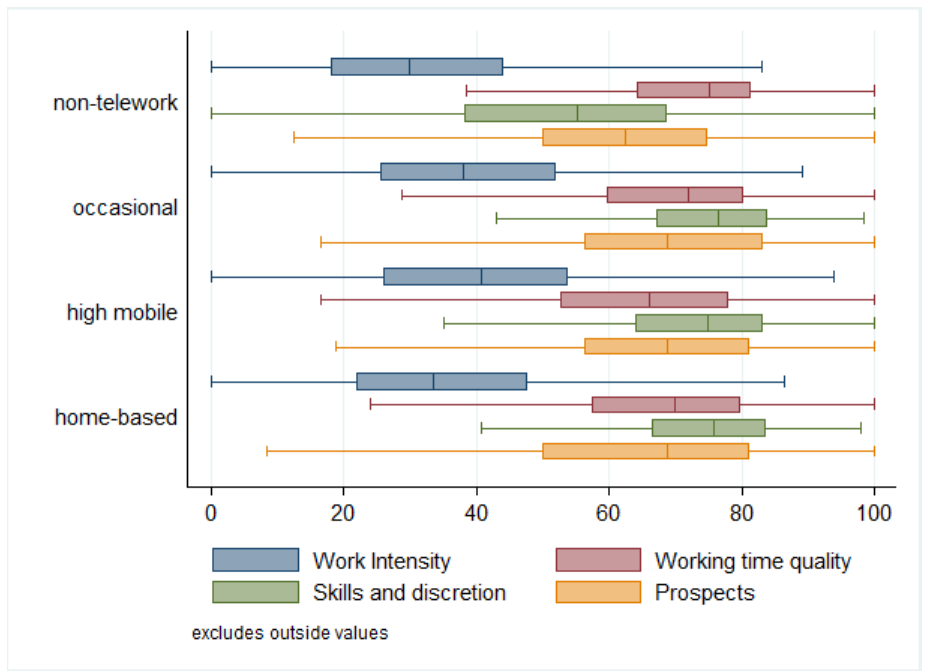
Figure 1. Distribution of indices by type of telework in the EU28 (weighted). Note: The boxes show the range of the values of the index for the middle 50% of the respondents. Lines show the range P5 to P95 for the middle of 90% of the respondents. Source: Own elaboration based on Sixth European Working Conditions Survey (EWCS)